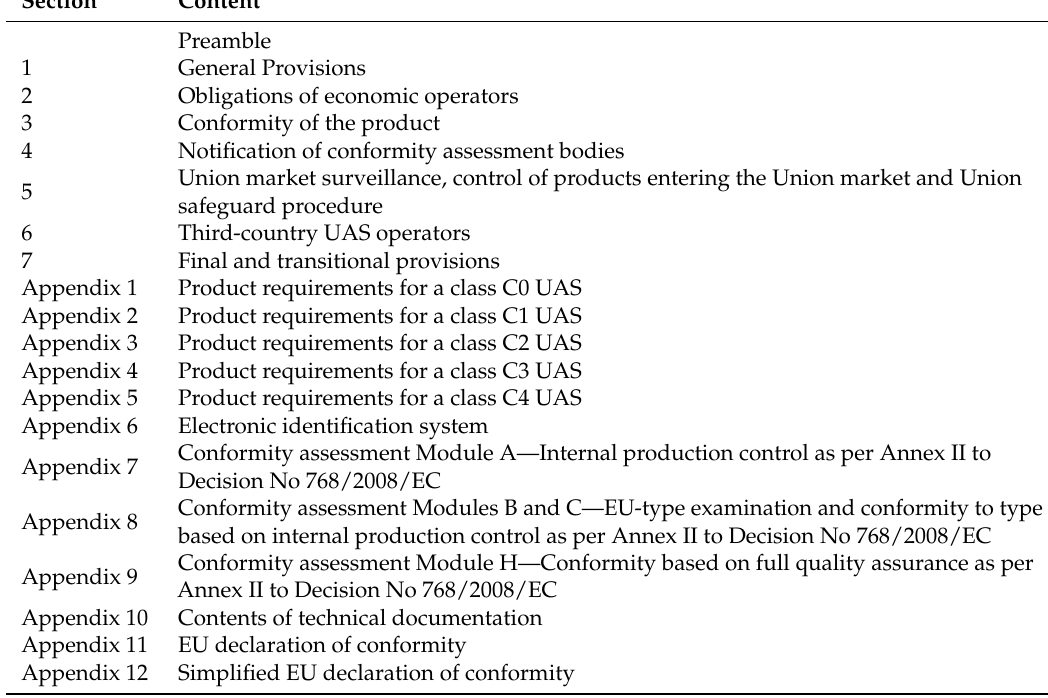
Table 1. Content of the UAS Market Regulation